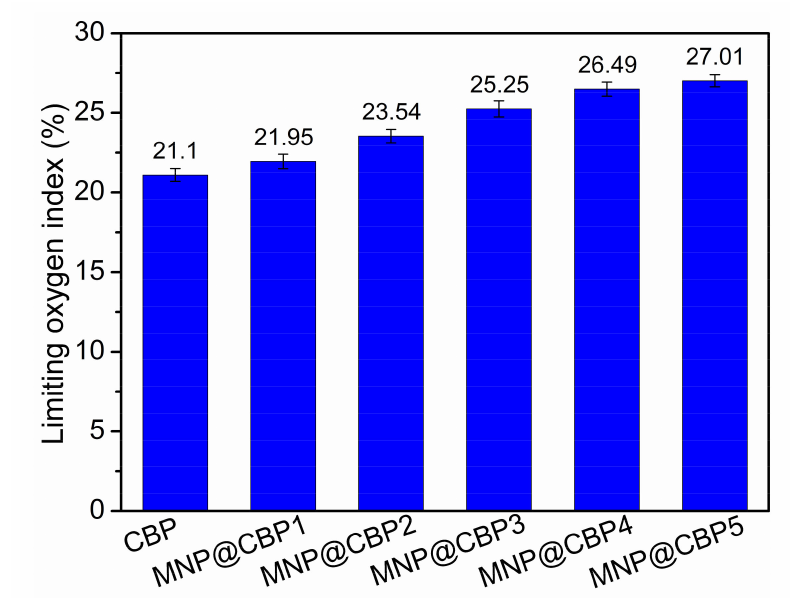
Figure 11. Limiting oxygen index of CBP and